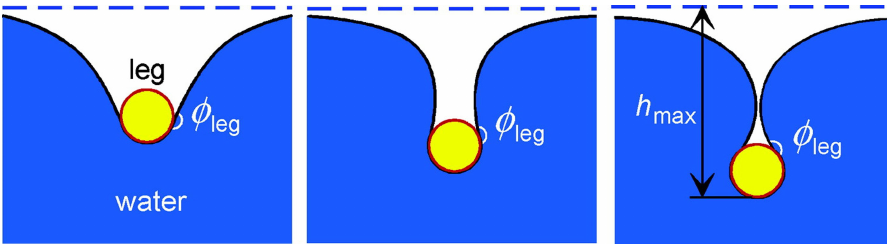
Figure 5. Contact angle of the leg and dimple depth. Dependence of contact angle on leg’s diameter in order to form maximal dimple with depth h Feng et al.